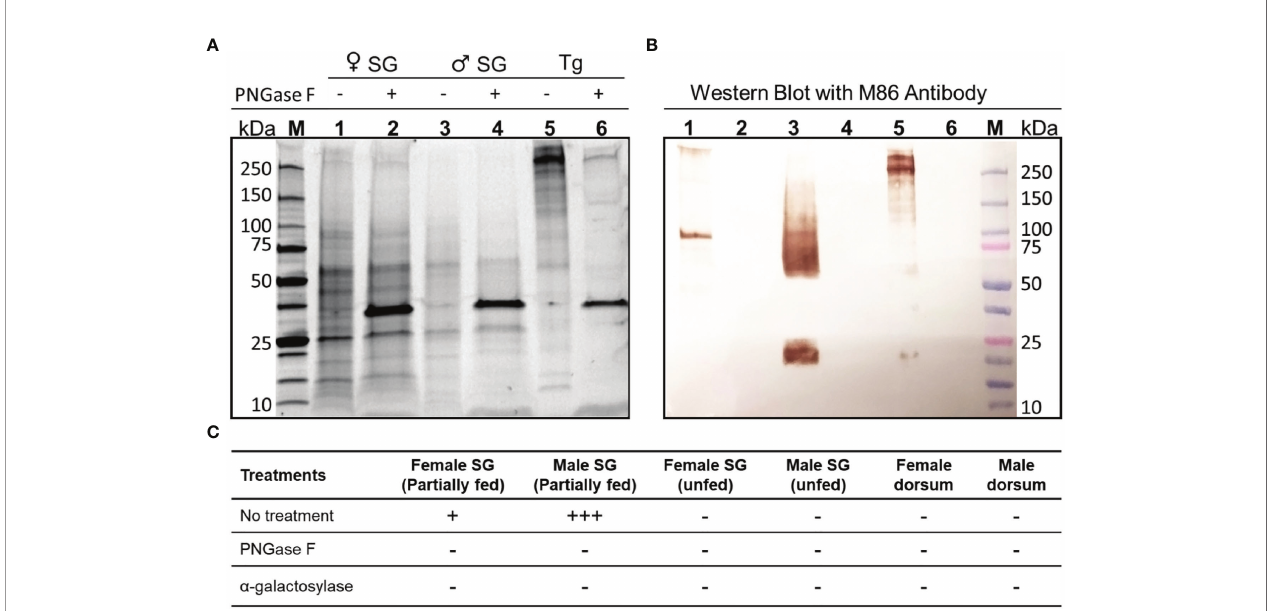
FIGURE 2 | Western blot for aGal immunoreactivity in the salivary glands of female and male A. americanum . (A) SDS-polyacrylamide gel for the female and male salivary gland (SG) proteins (1.5 pairs per lane) and bovine thyroglobulin (Tg) as the positive control. The samples were treated with PNGase F (shown by ~35kDa bands in samples 2, 4, and 6). (B) Western blotting with mouse monoclonal anti- aGal IgM is shown. (C) Summary of repeated experiments with different types of samples (column headings) with different enzymatic deglycosylations. The ‘ + ’ indicates the arbitrary strengths of aGal reactivity, while the ‘ - ’ is for lack of the